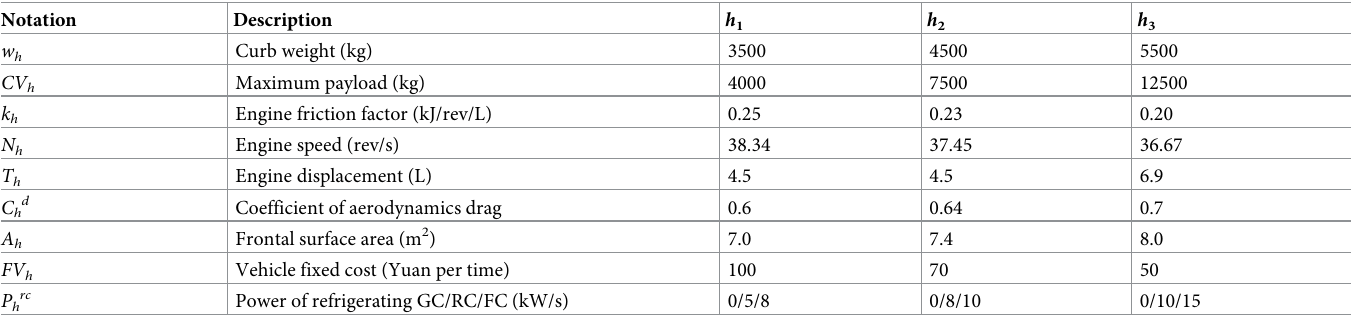
Table 2. Vehicle-specific